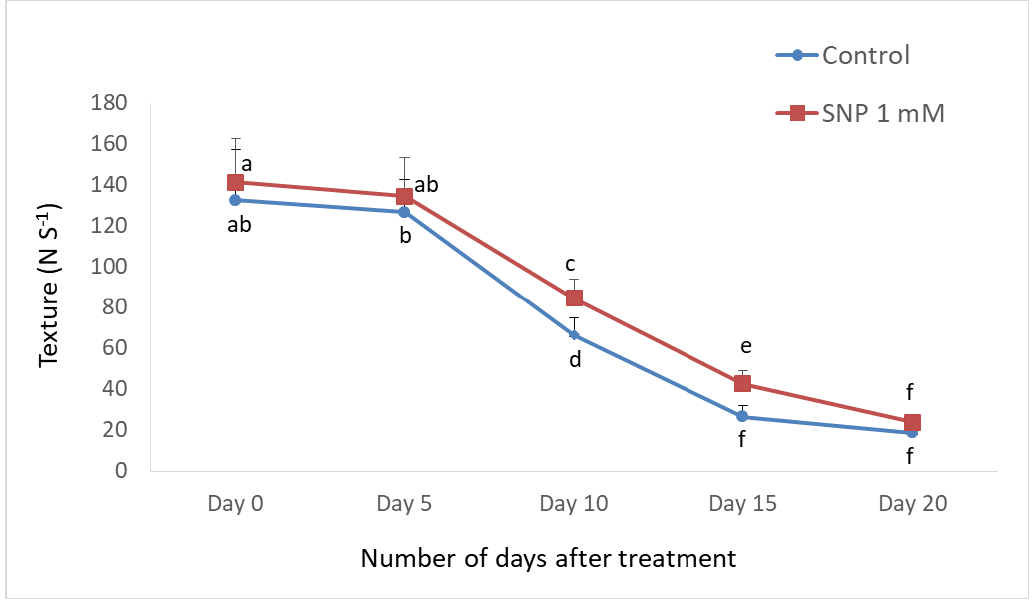
Figure 2. Effect of sodium nitroprusside on texture of banana fruit. Measurements were taken once in every 5 days.